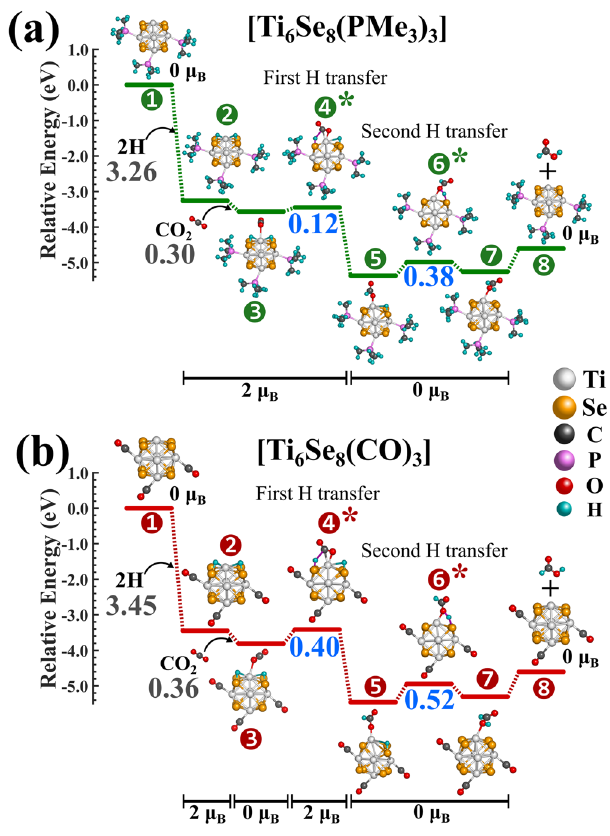
Fig. 3 CO 2 → HCOOH conversion on the Ti 6 Se 8 (PMe 3 ) 3 and Ti 6 Se 8 (CO) 3 clusters. The most favorable CO 2 → HCOOH conversion pathways on the ( a ) Ti 6 Se 8 (PMe 3 ) 3 and b Ti 6 Se 8 (CO) 3 clusters. The binding energies of H and CO 2 are shown in grey, barrier heights are shown in blue color. The transition states are marked with asterisk (*)